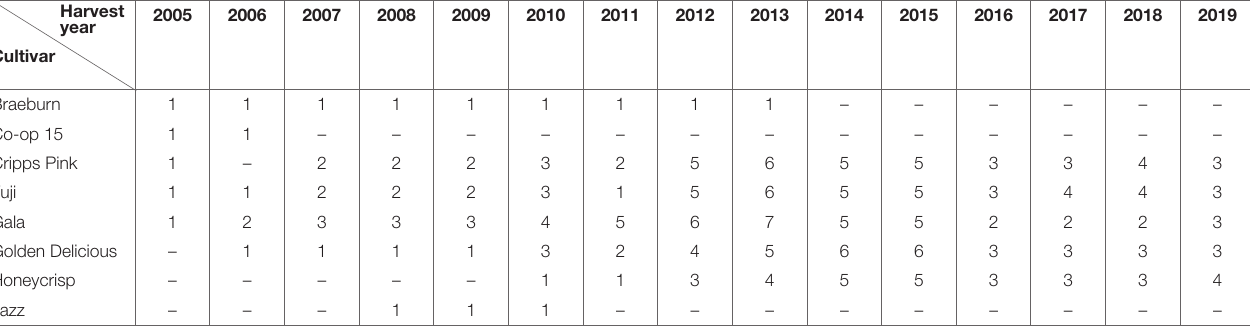
TABLE 1 | Reference cultivars represented in the phase two evaluation of the Washington State University apple breeding program for harvest years from 2005 to 2019.